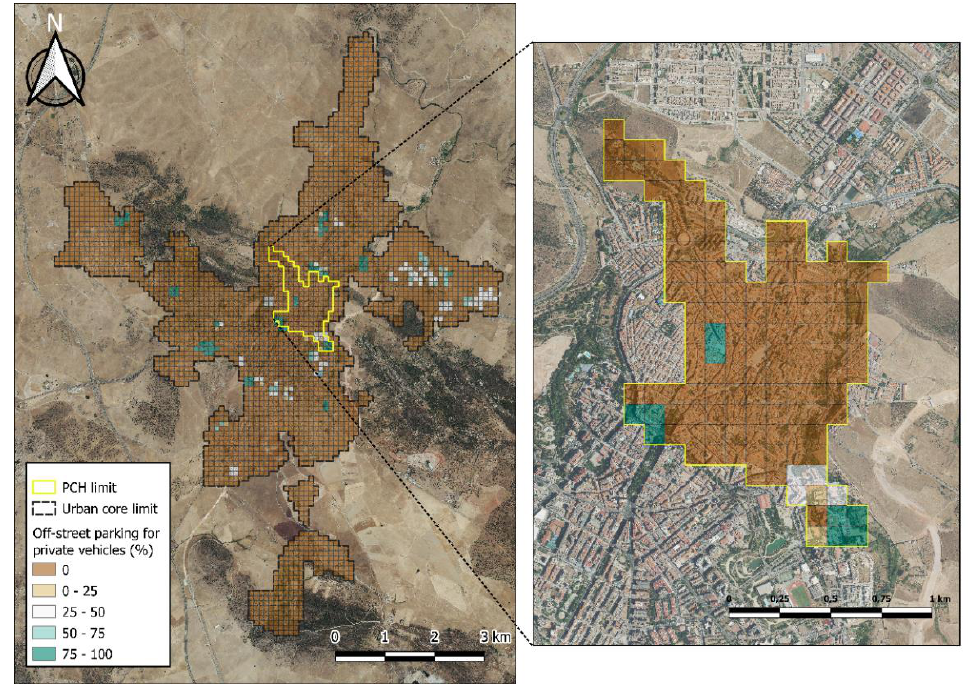
Figure 13. Off-street parking for private vehicles comparison.